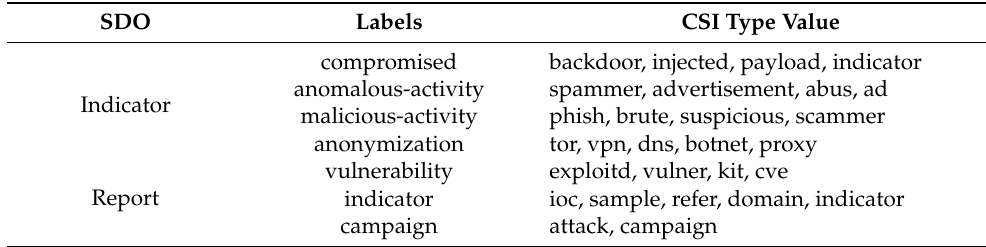
Table 2. Mapping method of labels and CSI